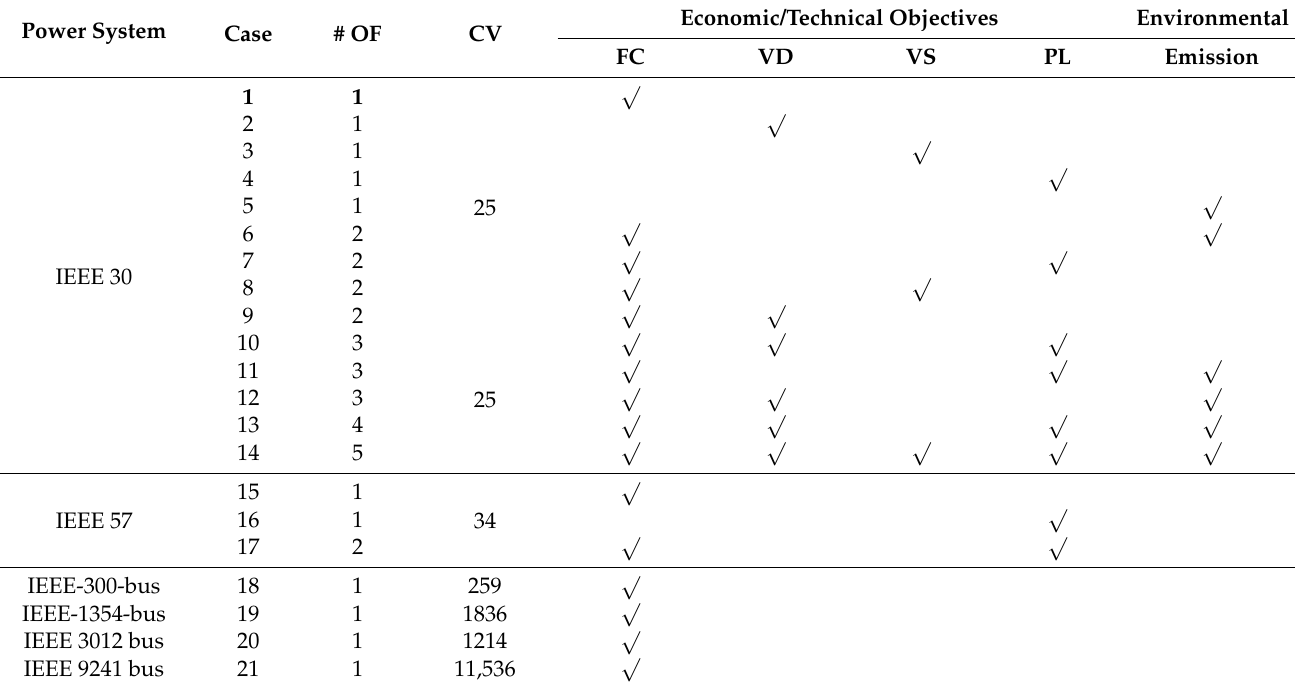
Table 1. Test cases of single and multi-objective functions in OPF problem.